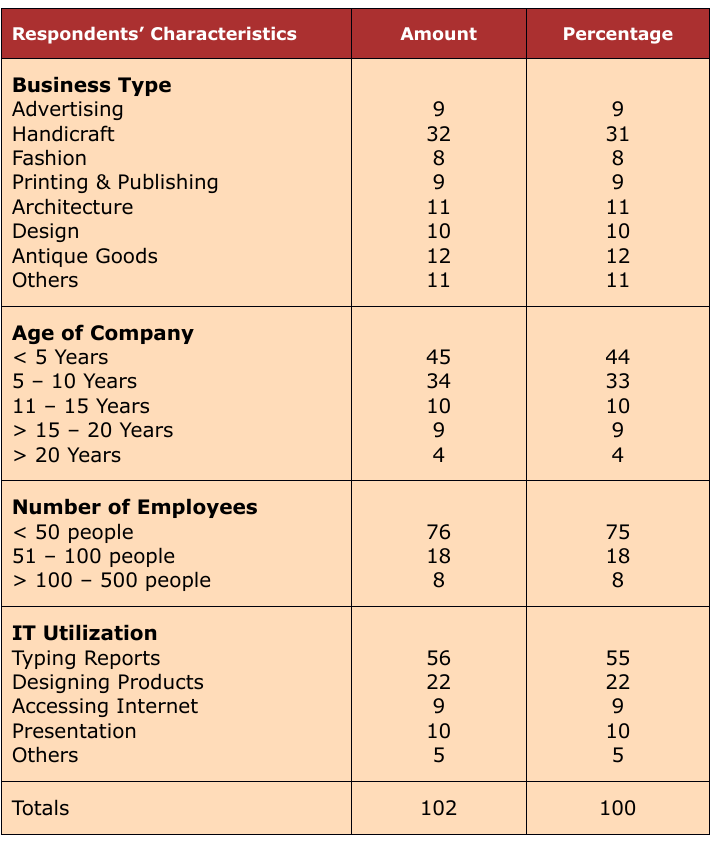
Table 2. Respondents’